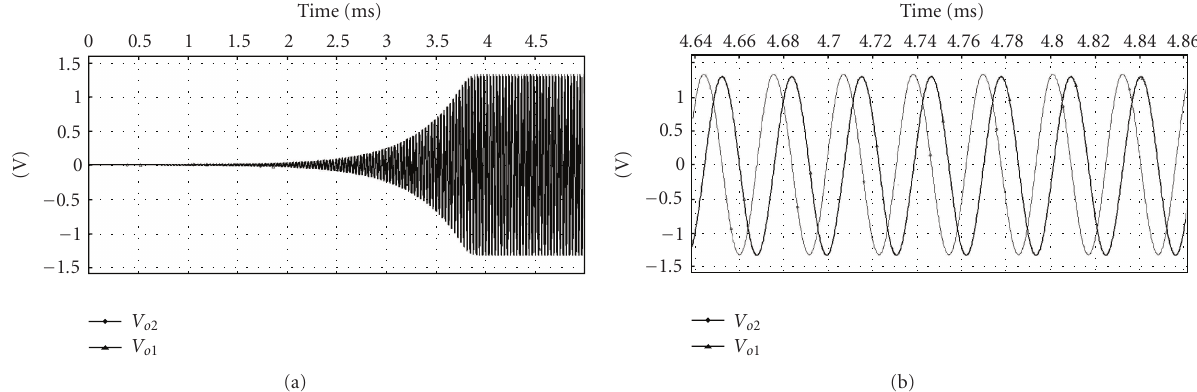
Figure 6: Quadrature oscillator in Figure 2(b): (a) startup of oscillations and (b) steady-state waveforms.